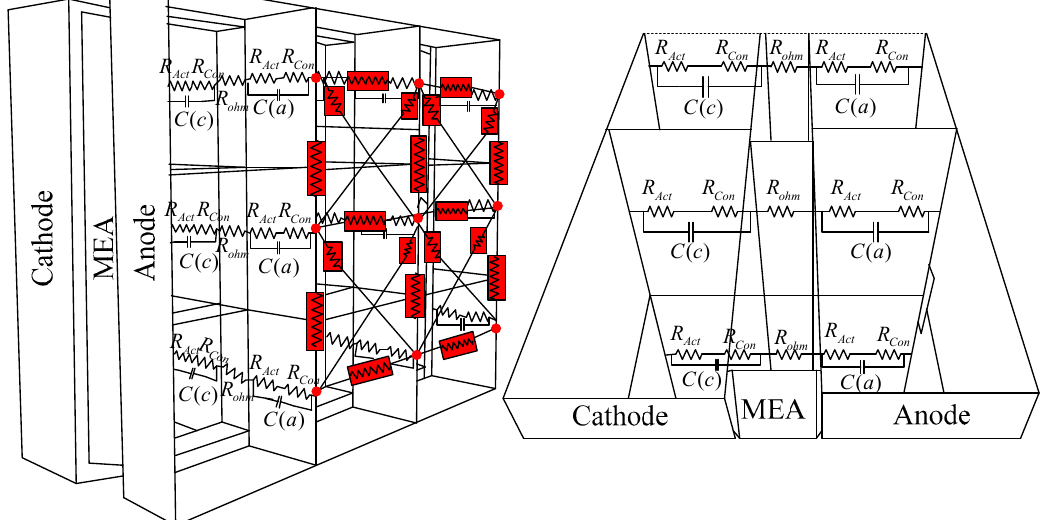
Figure 1. Geometrical representation of PEMFC 3D model (left—Perspective View, right—Top view).